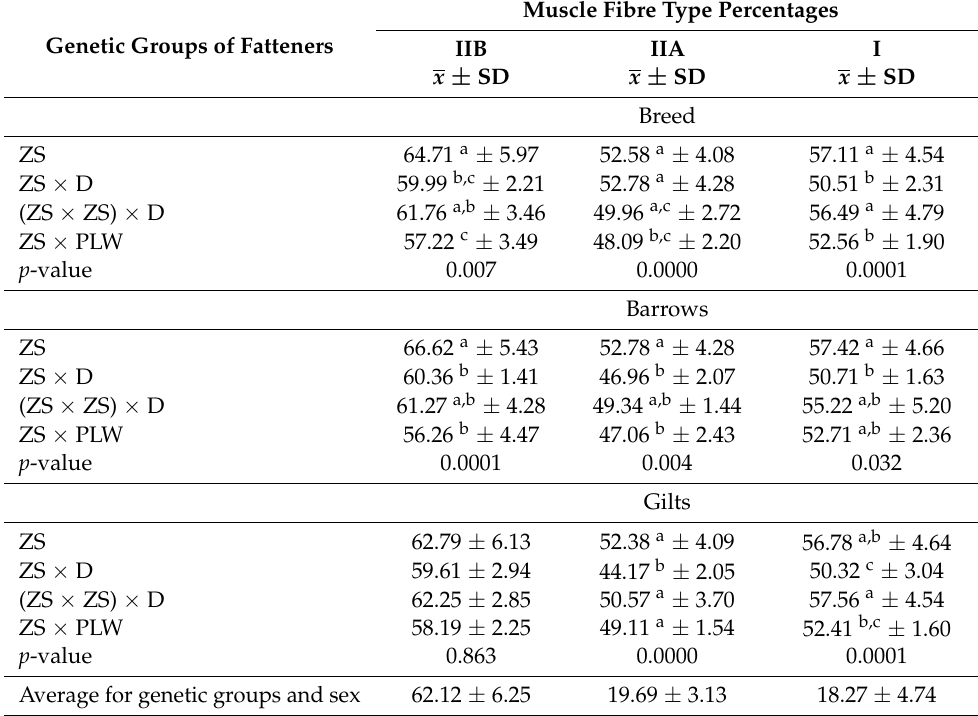
Table 3. Effect of breed or crossing of fatteners on muscle fibre type size (Ø µ m) of m. longissimus thoracis .